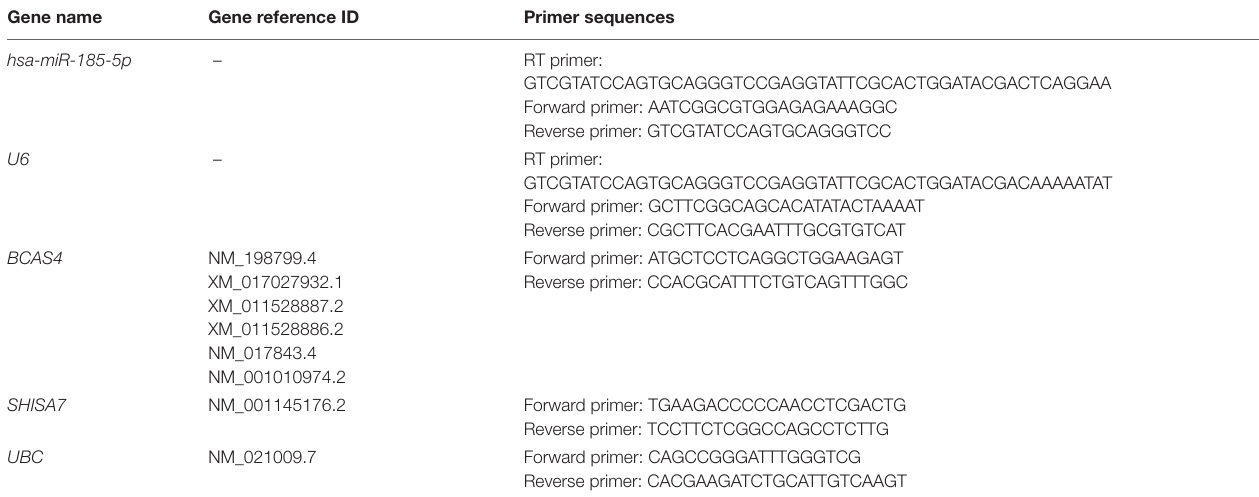
TABLE 1 | Sequences of primers used in reverse transcription (RT) and qPCR